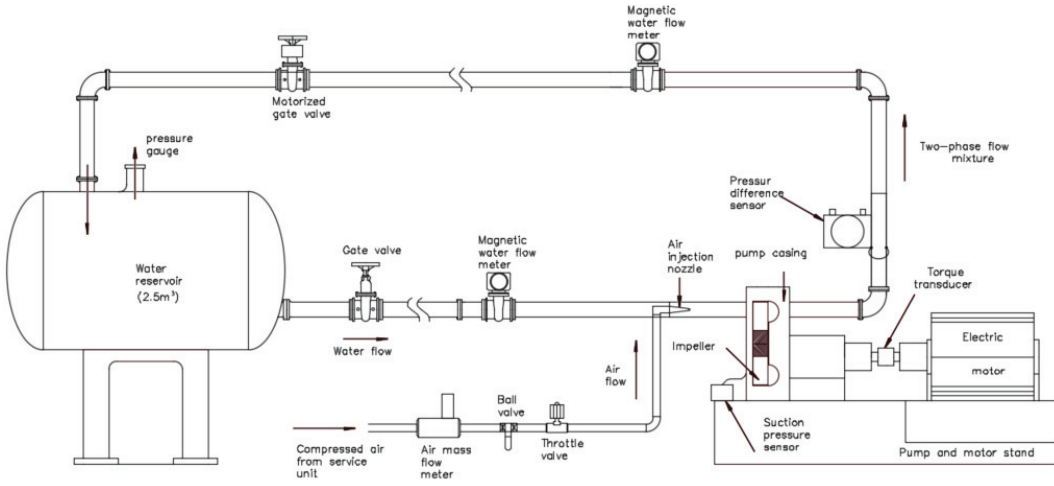
Figure 8. Experimental setup.